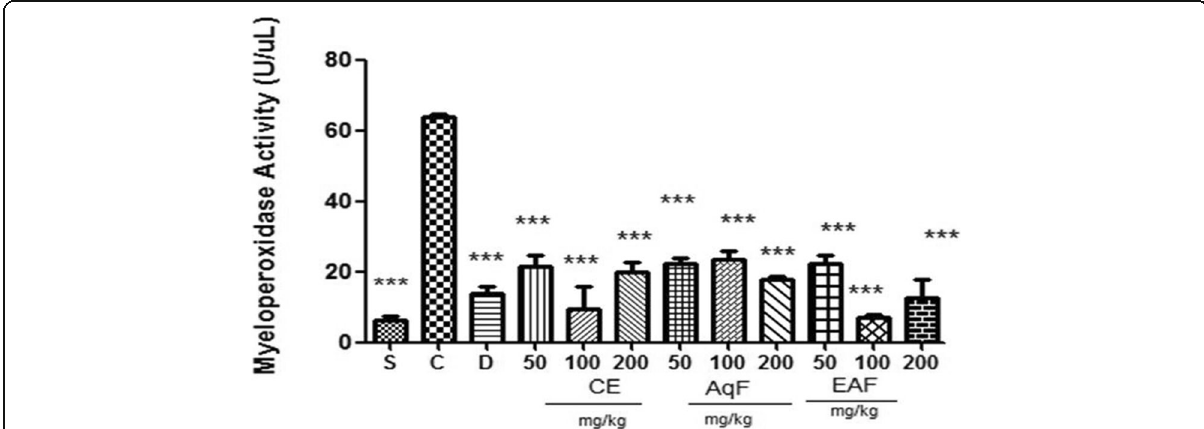
Fig. 3 Effect of the CE and fractions (50, 100 or 200 mg/kg) of E. uniflora Linn on MPO activity in a carrageenan induced peritonitis model versus the carrageenan group. Data are expressed as the mean ± standard mean error ( n = 5). An ANOVA test was used to calculate statistical significance, *** p <0.001 versus the positive control group. S (Sham), C (carrageenan), D (diclofenac), CE (crude extract), AqF (aqueous fraction), EAF (ethyl acetate-treated